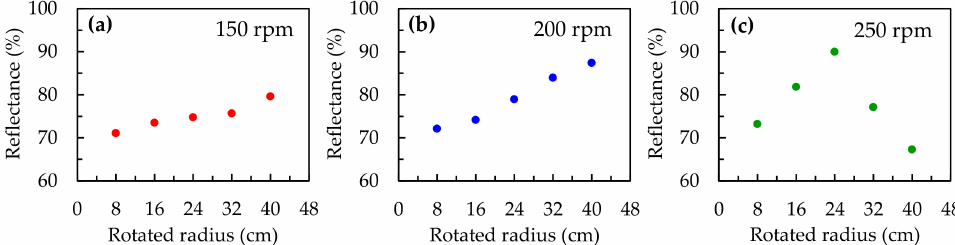
Figure 2. Variation in the reflectance values of samples stacked at different positions with rotational speeds of ( a ) 150 rpm; ( b ) 200 rpm; and ( c ) 250